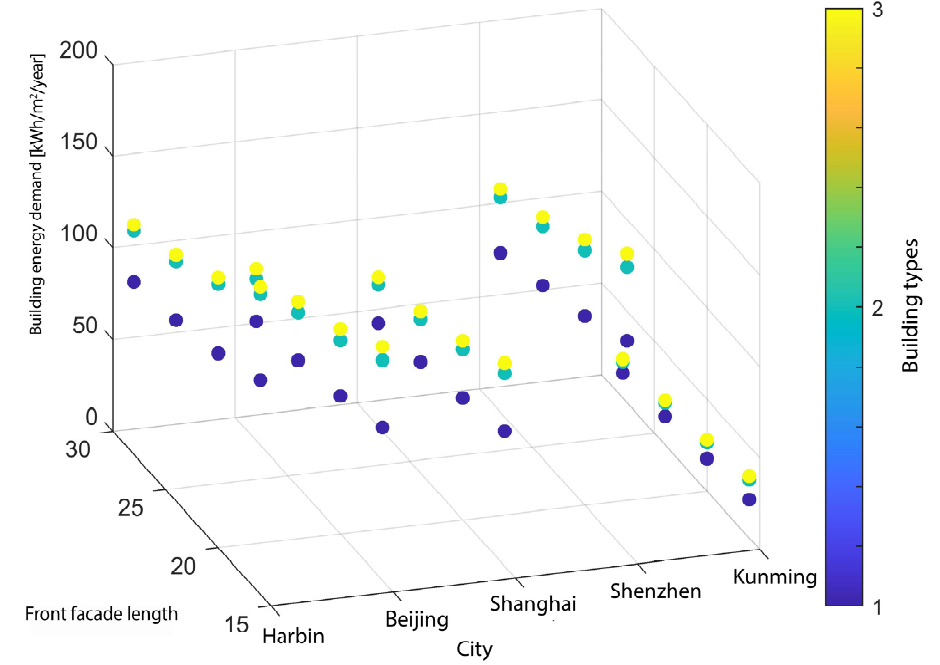
Figure 23. Relationship between the length of the front elevation and the building energy